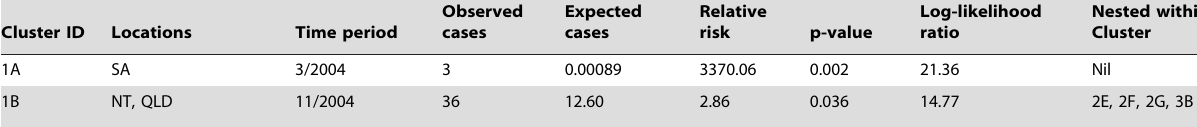
Table 2. Significant clusters identified by national cluster